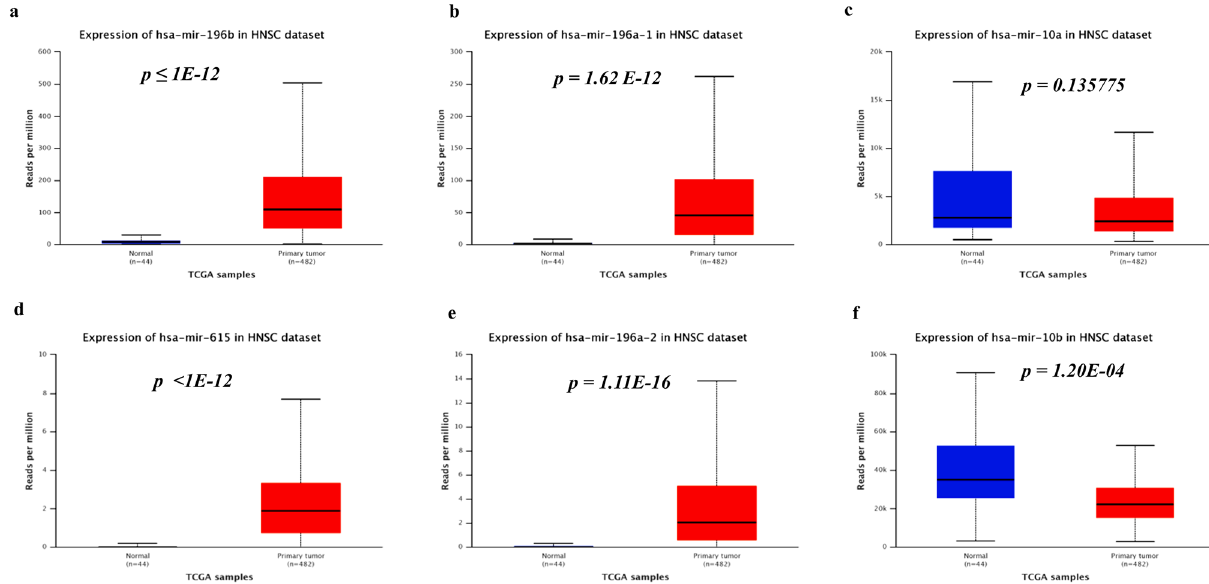
Figure 6. DEHMs in HNSCC: ( a – f ) The box plots representing the gene expression of HOX-embedded miRNAs in HNSCC, analyzed using UALCAN.